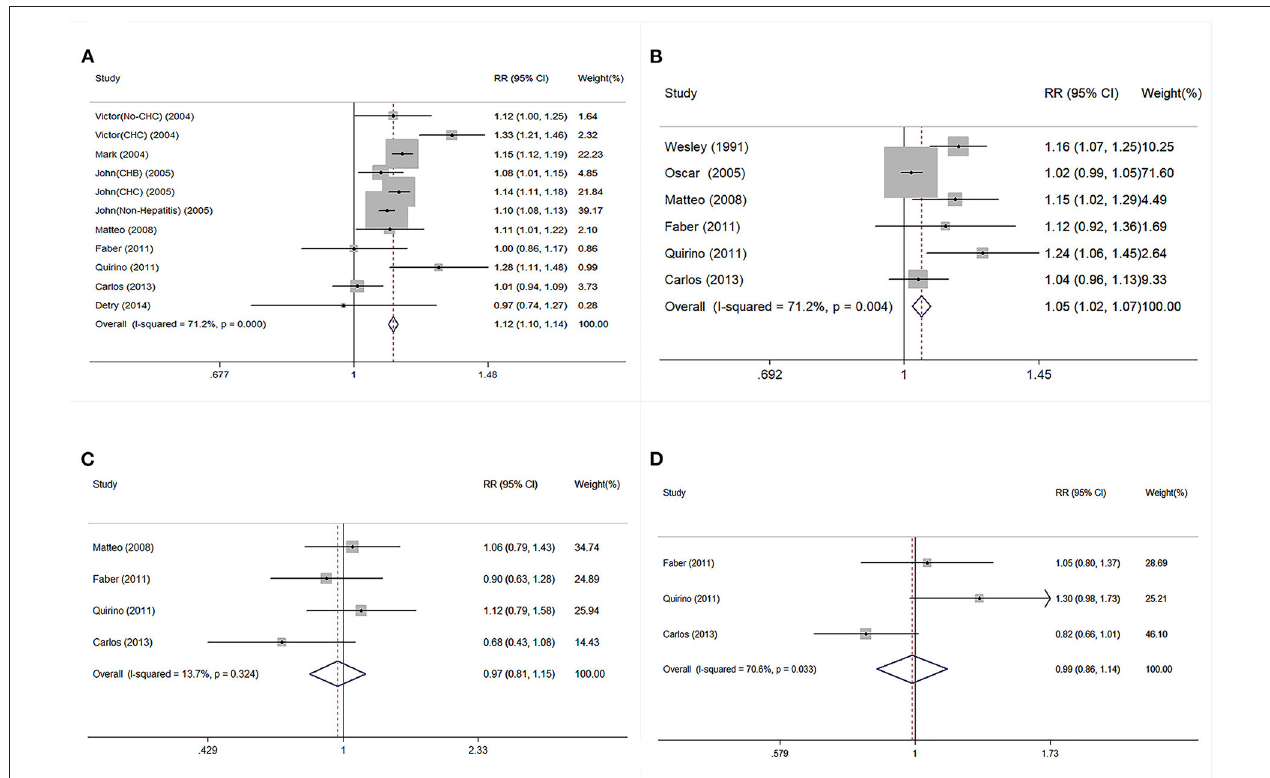
FIGURE 4 | Continuous risk of post-transplant outcomes was evaluated followed per 10-year increment on donor age in linear model. (A) Pooled RR of GF followed per 10-year increment on donor age. (B) Pooled RR of patient death followed per 10-year increment on donor age. (C) Pooled RR of PNF followed per 10-year increment on donor age. (D) Pooled RR of re-transplantation followed per 10-year increment on donor age. RR, relative risk; GF, graft failure; PNF, primary non-function.